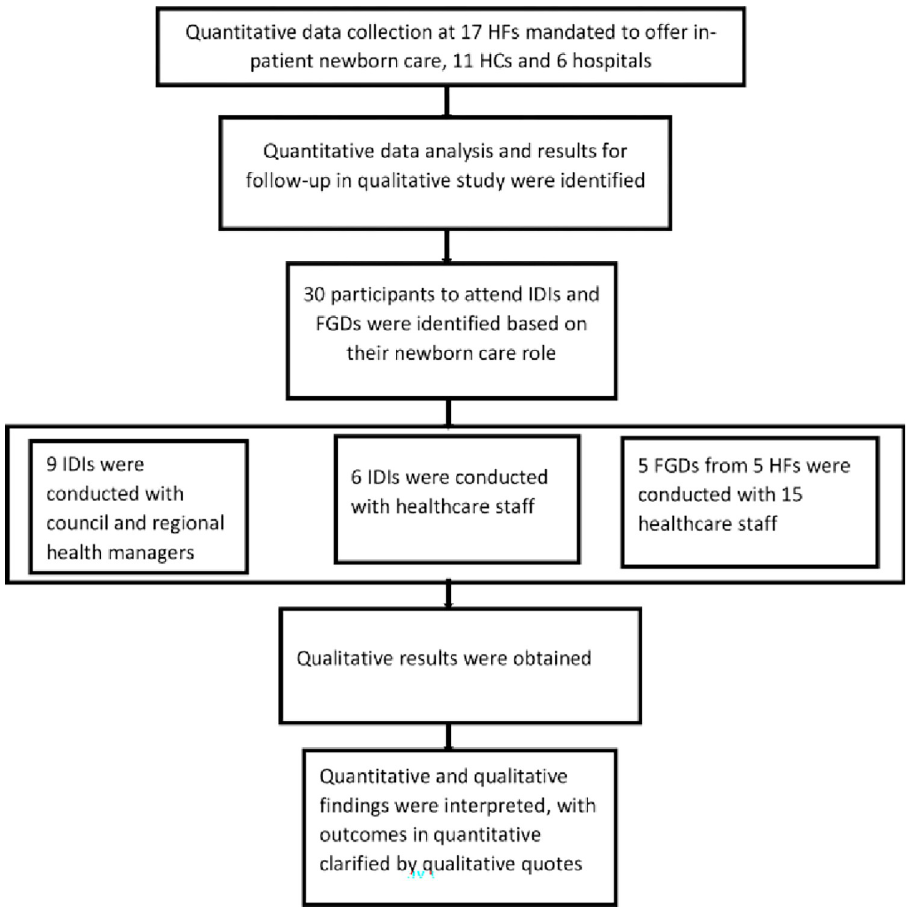
Fig 1. Flow chart of the study